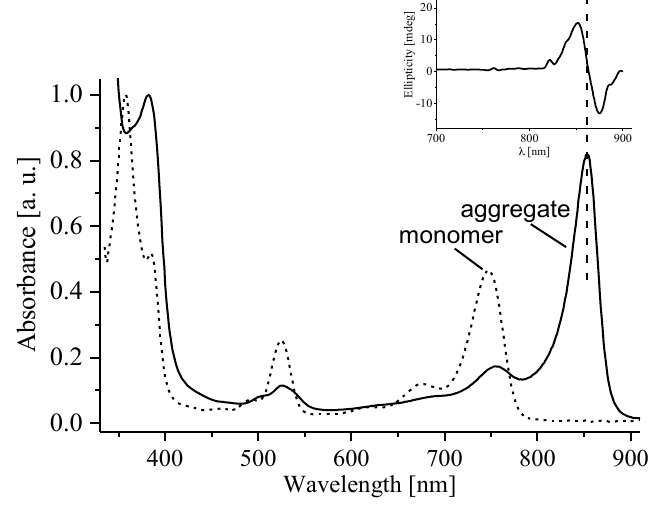
Figure 4. Electronic absorption spectra of monomeric (in acetone) and aggregated BPheo in β -OG micellar system. In the insert, the circular dichroism spectrum of the aggregated form is shown. All the measurements were performed in 1 cm quartz cells at ambient